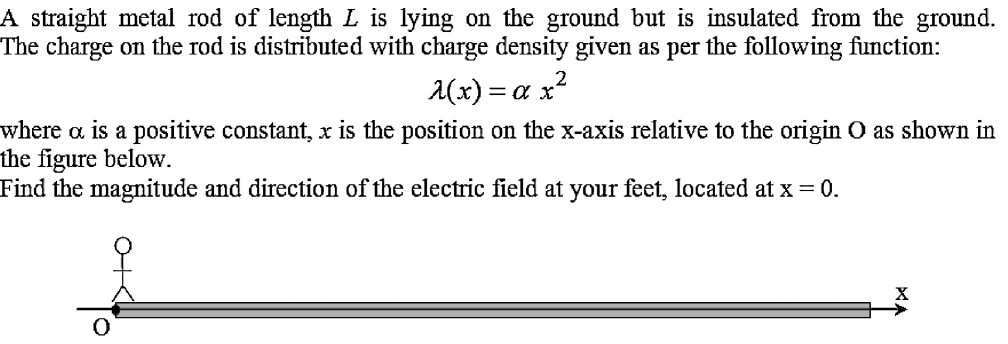
FIG. 2. The charged rod problem (interview